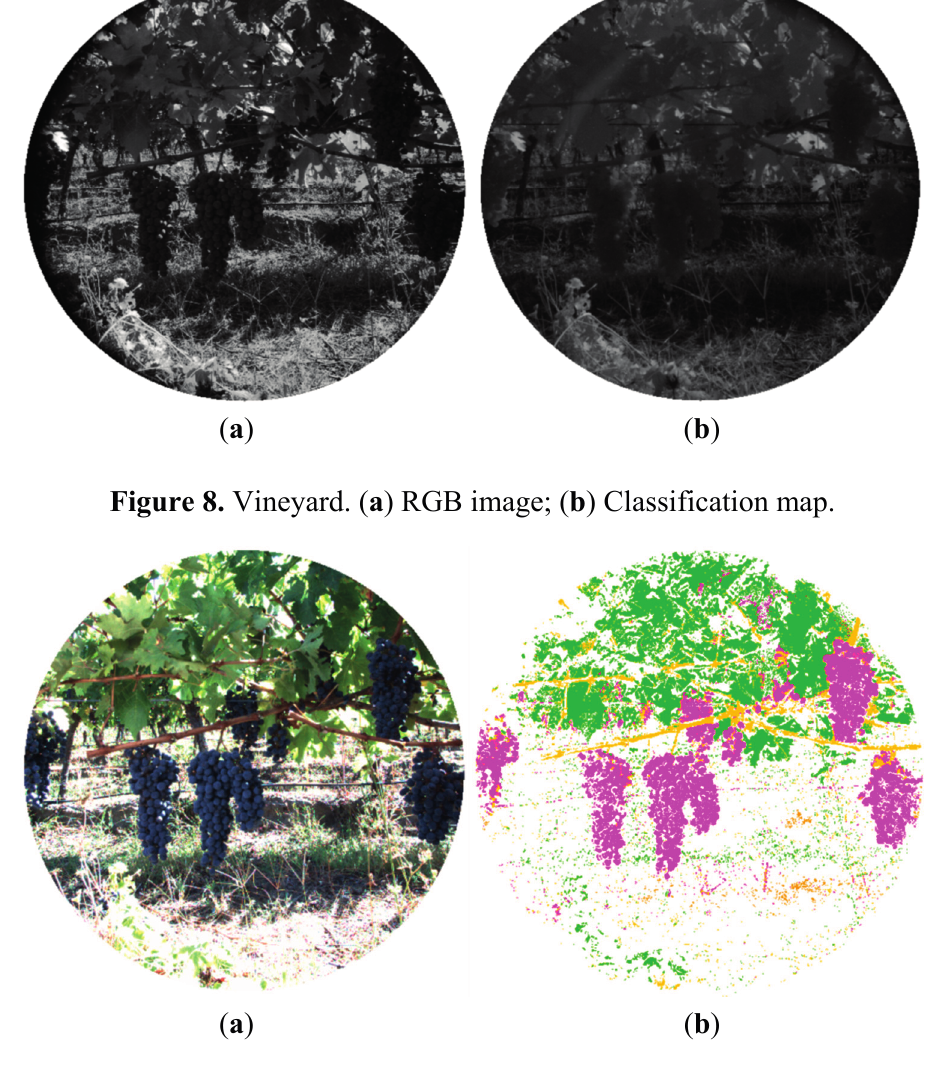
Figure 9. Vineyard. ( a ) RGB image; ( b ) Centroid and area calculation for each blob that satisfies the predefined requisites to be a fruit candidate for